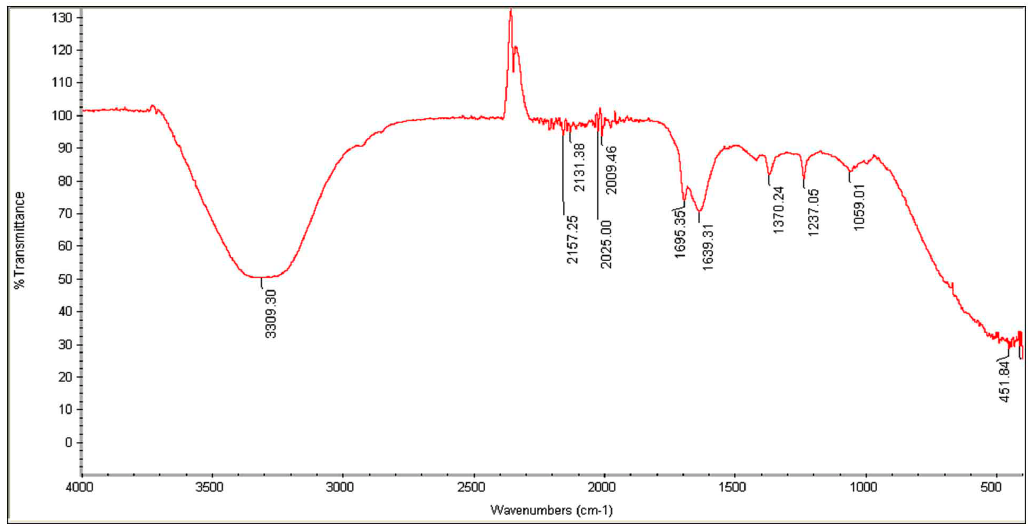
Fig. 2. FTIR spectrum for passion fruit with pulp and seeds (acetone